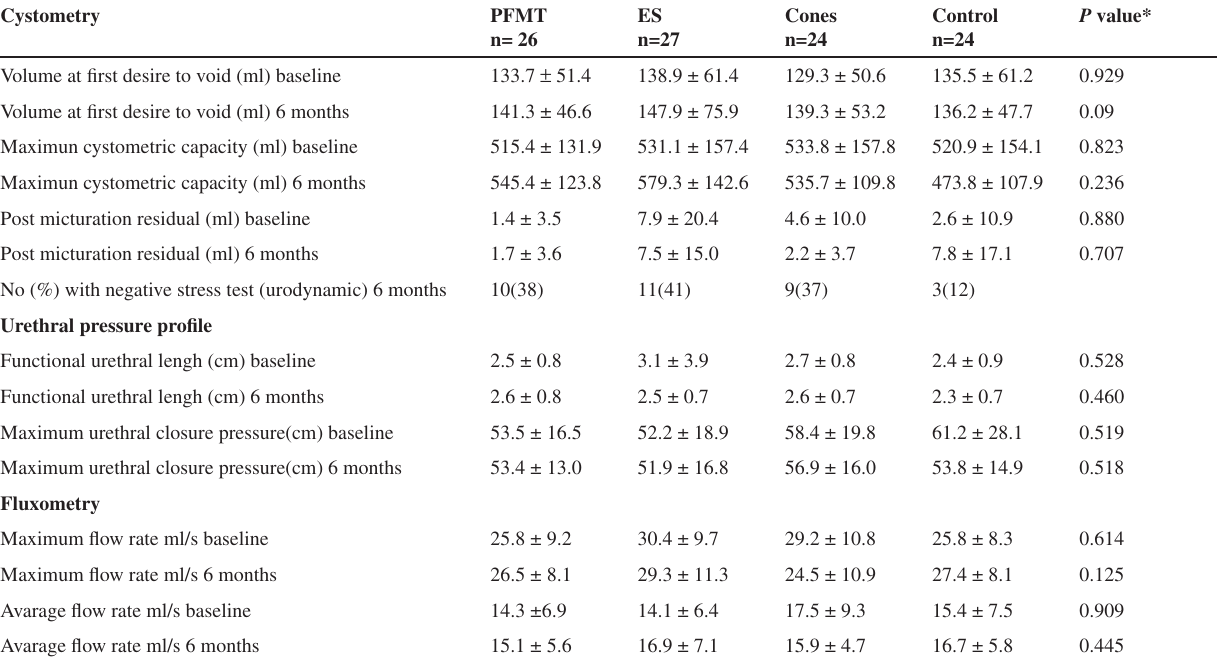
Table 4 - Urodynamic data at baseline and 6 months after treatment